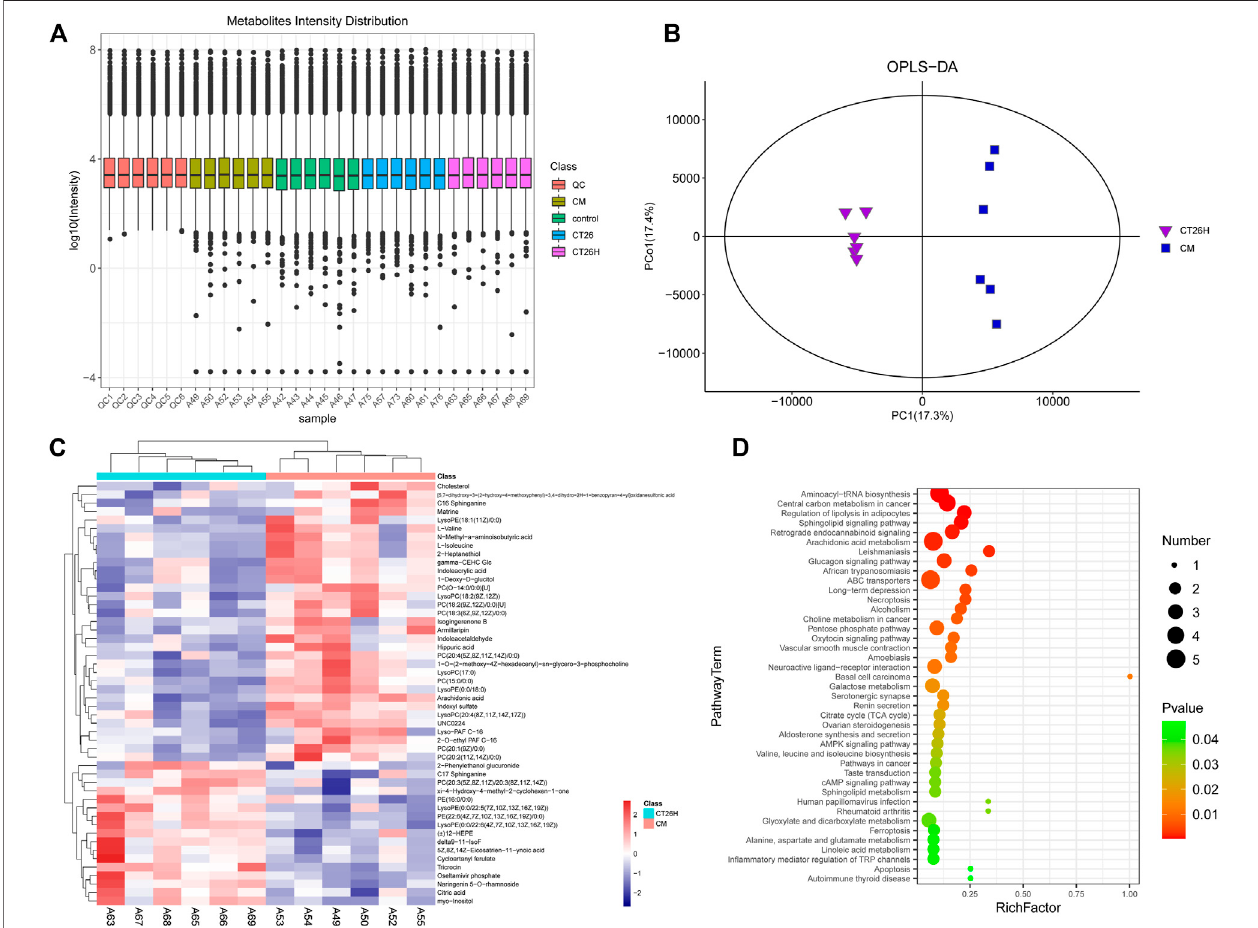
FIGURE 3 | Mass spectrum of serum metabolism in the CT26H and CM groups. (A) Metabolites Intensity Distribution box plot of all samples. (B) OPLS-DA score plotoftheCT26HandCMgroups. (C) Heatmapofthetop50differentialmetabolitesbetweentheCT26HandCMgroups. (D) KEGGpathwaysenrichedbysigni fi cantly different metabolites between the CT26H and CM groups ( p <